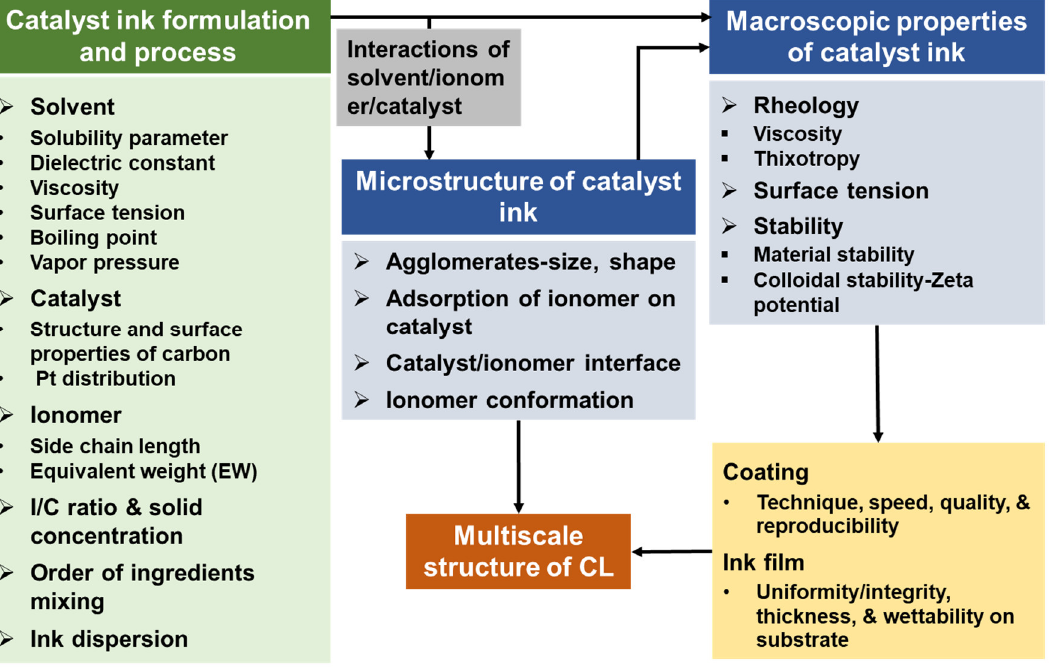
Figure 4. The effect of the formulation and preparation processes of catalyst ink on its microstructure and macroscopic properties and further on the fabricated CLs.